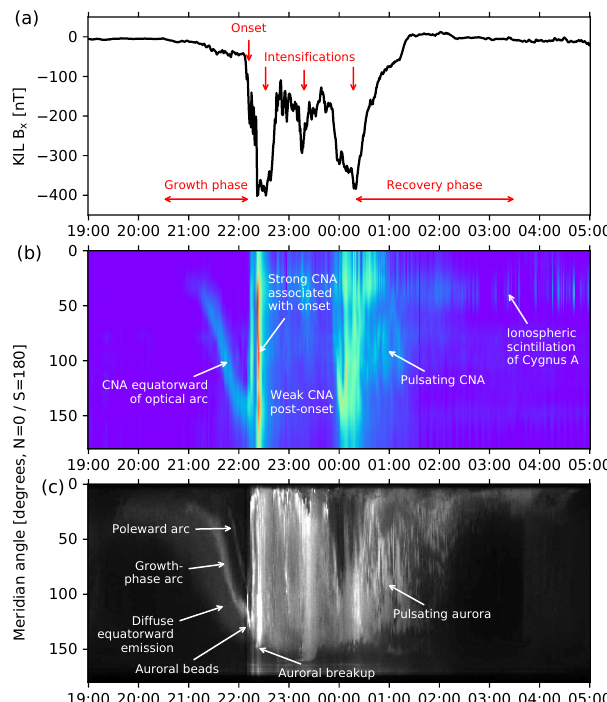
Figure 1. An example event with the distinct signatures of the sub- storm indicated. Panel (a) is the magnetic signature, panel (b) is the riometric keogram from KAIRA and panel (c) is the optical 557.7nm emission observed with the FMI-ASC at Kilpisjärvi.